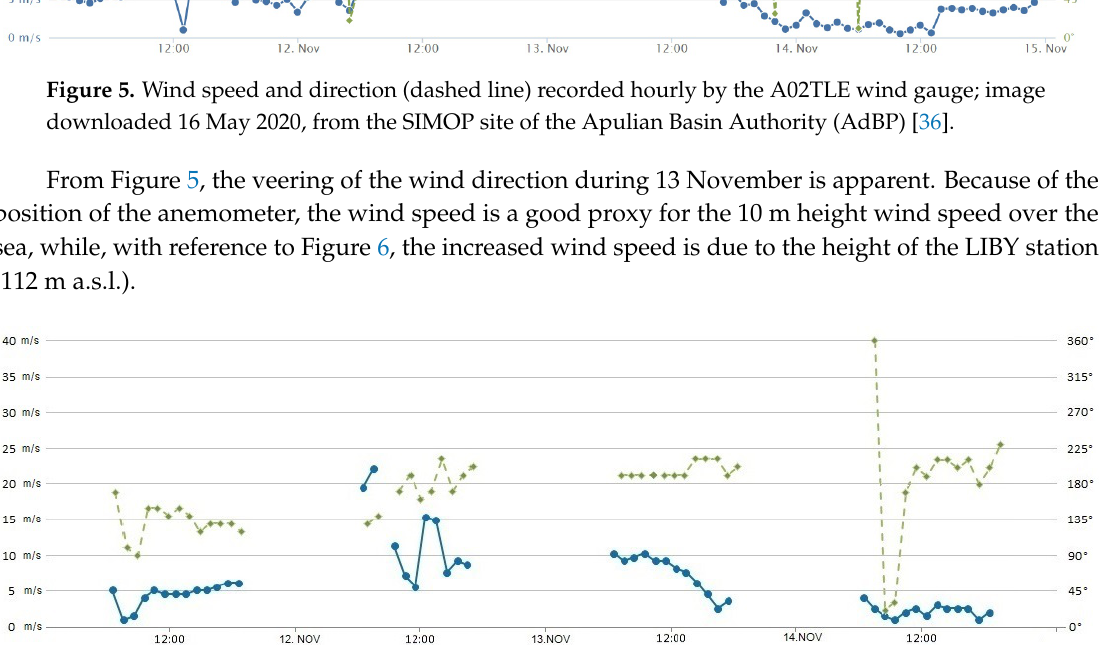
Figure 6. Wind speed and direction (dashed line) recorded hourly by the LIBY station; image drawn using the data downloaded 11 December 2019, from the OGIMET site